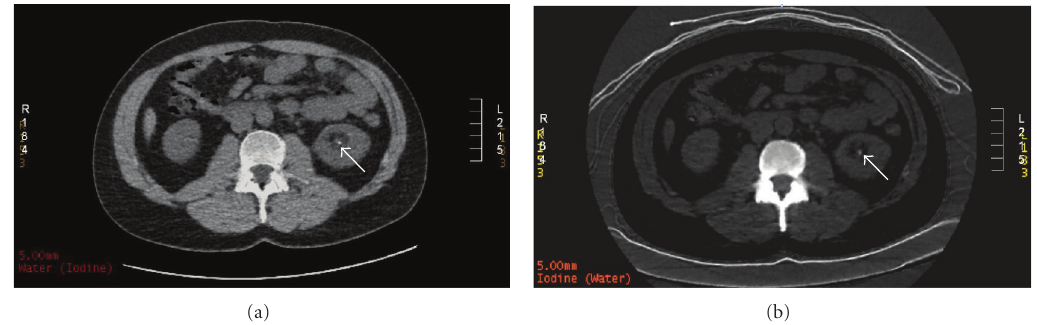
Figure 2: A 34-year-old male presenting with left flank pain. Axial dual energy noncontrast CT. (a) shows a 3mm calculus in the left renal pelvis on iodine and (b) water-based attenuation. As the calculus is visible on both imaging techniques, this indicates high-molecular-weight elements. This calculus proved to be predominantly calcium based.